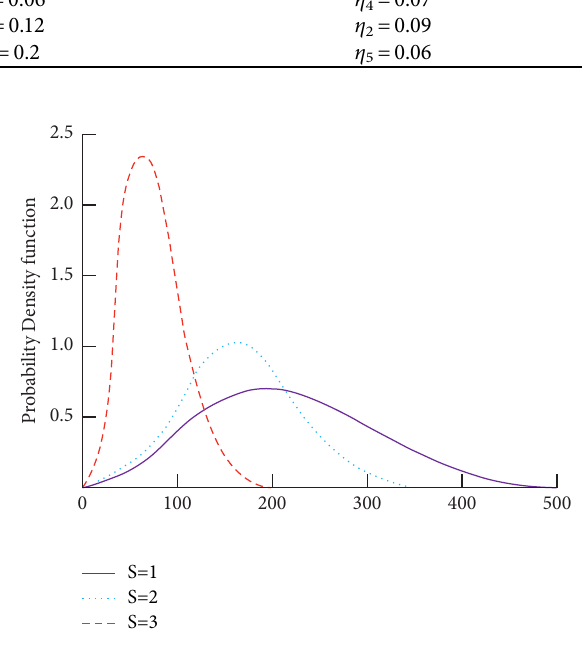
Figure 1: Probability density curve of service request sojourn time.